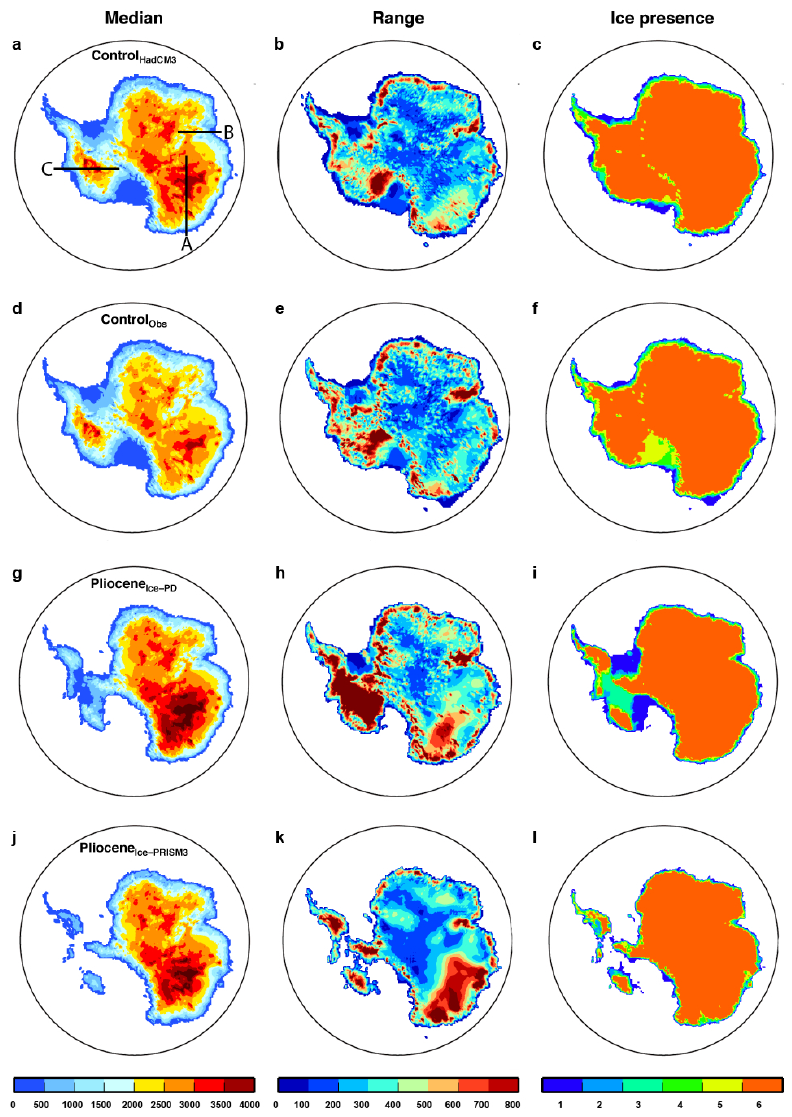
Figure 9. Median, range and coverages of grounded and floating ice thickness from the six ISM simulations with Bedmap1. From top to bottom shows the main four experiments. All six ice thickness values for all locations are sorted, the median is shown as the mean of the 3th and 4th value (in m), the range is the difference between the 6th and the 1st, divided by two and ice coverage counts if any ice is present (0: no ice, 6: all ISMs have ice). The black lines in (a) represent the cross sections shown in Fig. 10: A – Wilkes basin, B – Lambert ice stream and C – the